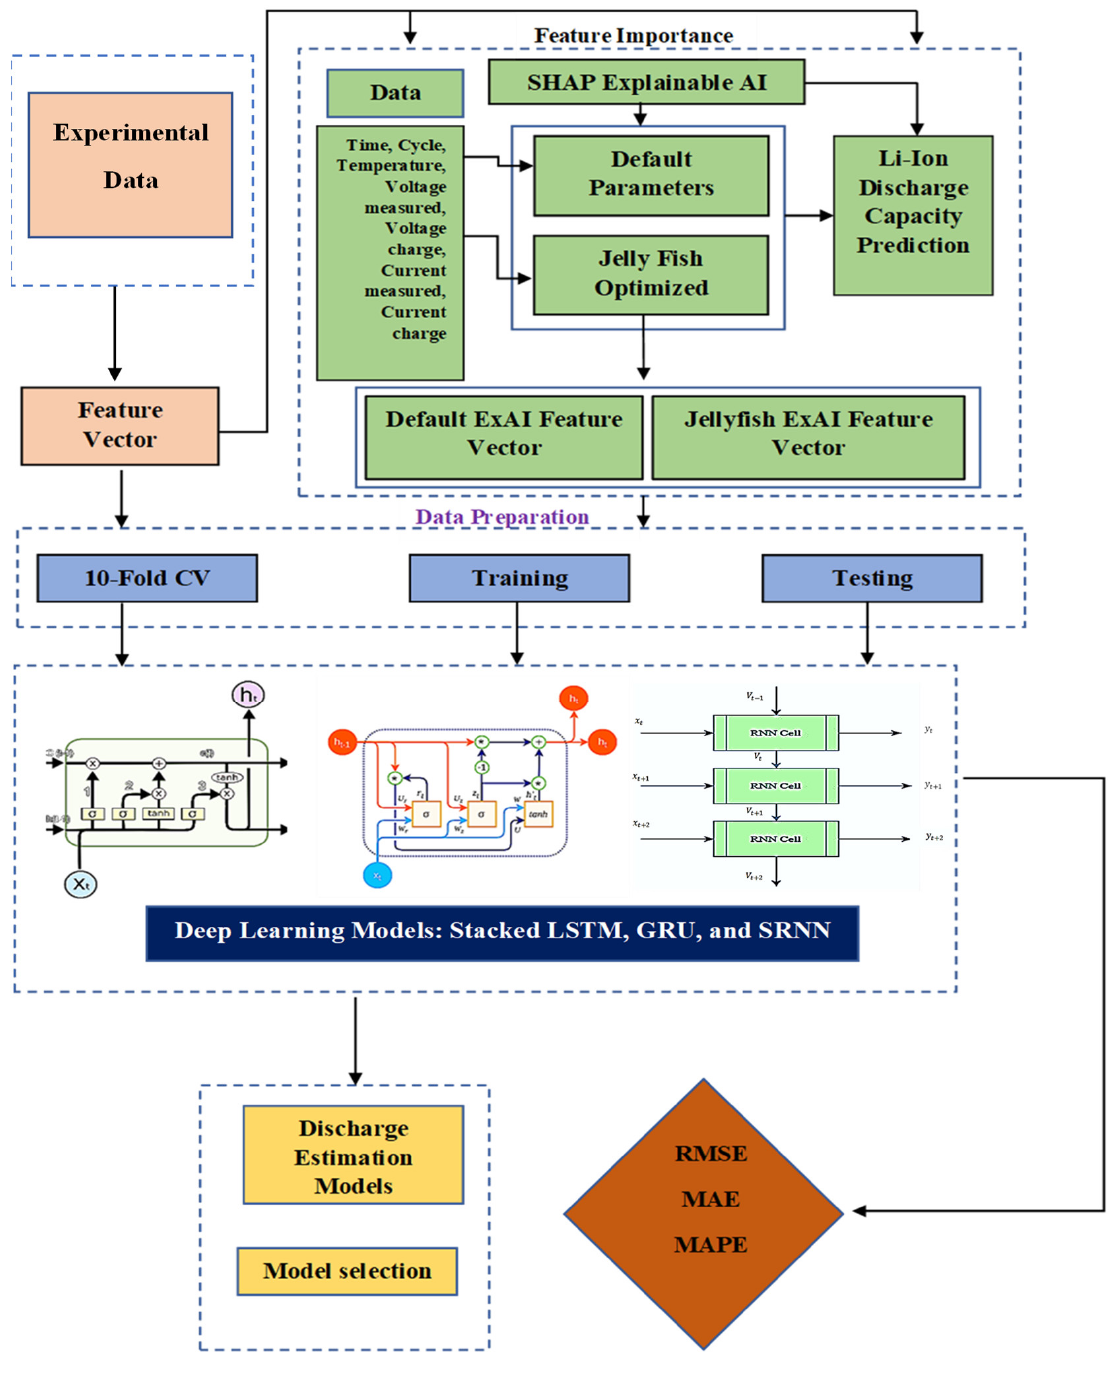
Figure 1. Ex-AI methodology to estimate Li-ion battery discharge